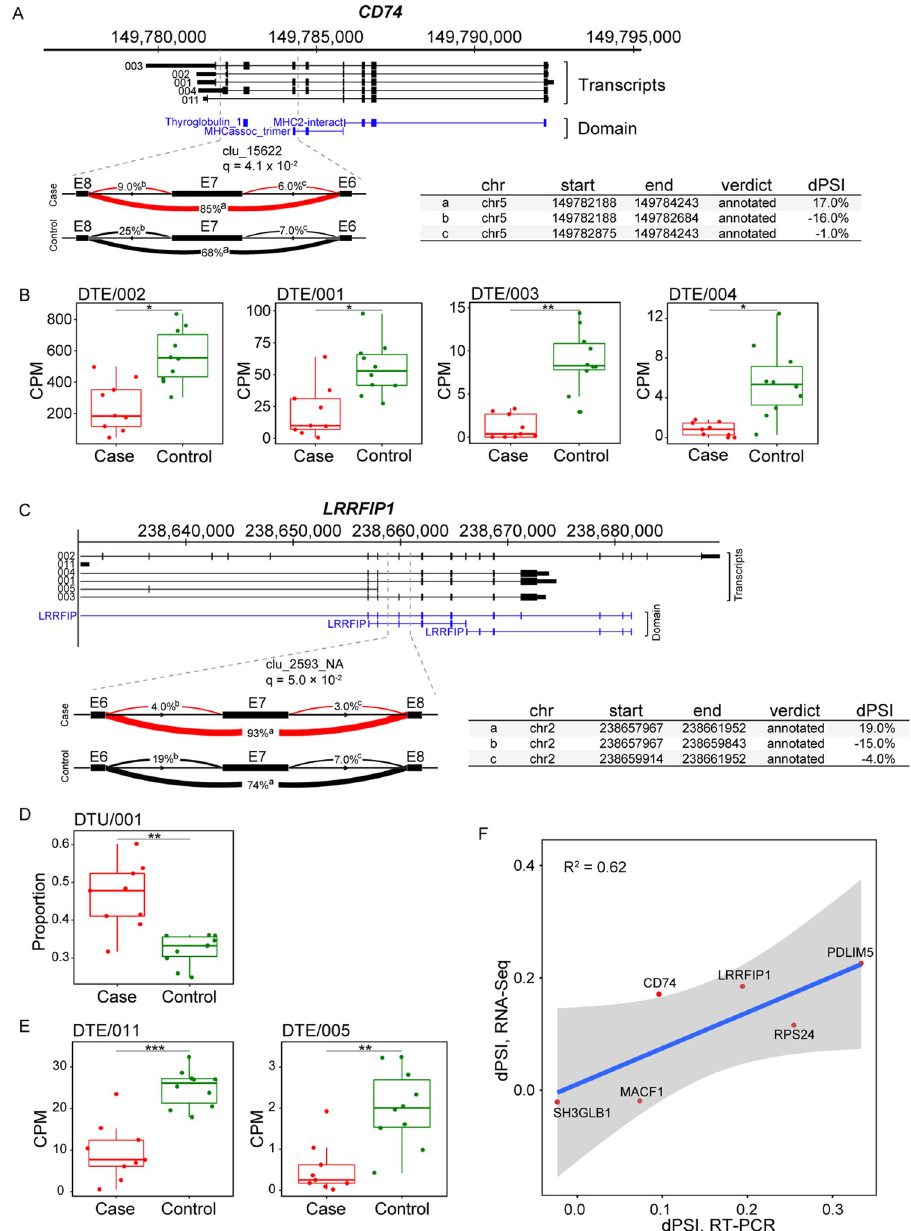
Fig 4. Aberrant local splicing and transcript isoform usage in COVID-19. (A) A significant differential splicing intron cluster in CD74 (clu_15622; chr5: 149,782,188–149,784,243) showing increased exon 7 (E7) skipping in COVID-19. Increased intron usage in COVID-19 cases compared to control is highlighted in red. Protein domains are annotated as thyroglobulin_1, thyroglobulin type 1 repeats; MHCassoc_trimer, Class II MHC-associated invariant chain trimerisation domain; MHC2-interact, MHC2 interacting. Visualization of splicing events in cluster clu_15622 with changes in PSI (dPSI) for COVID-19 group comparisons. FDR-corrected P values (q) are indicated for each comparison. Covariate-adjusted average PSI levels in cases (red) versus controls (black) are indicated at each intron. (B) Bar plots for changes in gene expression for CD74-002, CD74-001, CD74-003 and CD74-004. CD74-003 is the canonical sequence. � posterior probability > 0.5; �� posterior probability > 0.7; ��� posterior probability > 0.9. (C) Whole-gene view of LRRFIP1 highlighting (dashed lines) the intron cluster with significant differential splicing in COVID-19 (clu_2593_NA; chr2: 238,657,967–238,661,952). LRRFIP, Leucine-rich repeat flightless-interacting protein domain. (D and E) Bar plots for changes in transcript usage and gene expression for LRRFIP1 transcripts. � posterior probability > 0.5; �� posterior probability > 0.7; ��� posterior probability > 0.9. (F) Scatter plots comparing the average percent spliced-in (PSI) of exon skipping events called by LeafCutter from RNA-seq data to